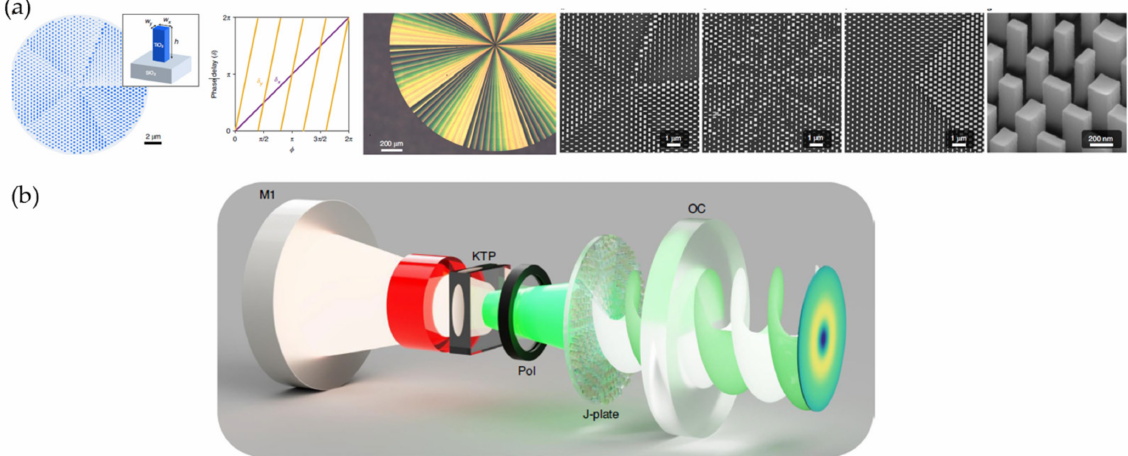
Figure 7. High-purity OAM states from a visible metasurface laser. ( a ) Design of new J-plate. ( b ) Schematic of the metasurface laser. Reprinted with permission from [124] © 2020, The Author(s), under exclusive license to Springer Nature Limited.